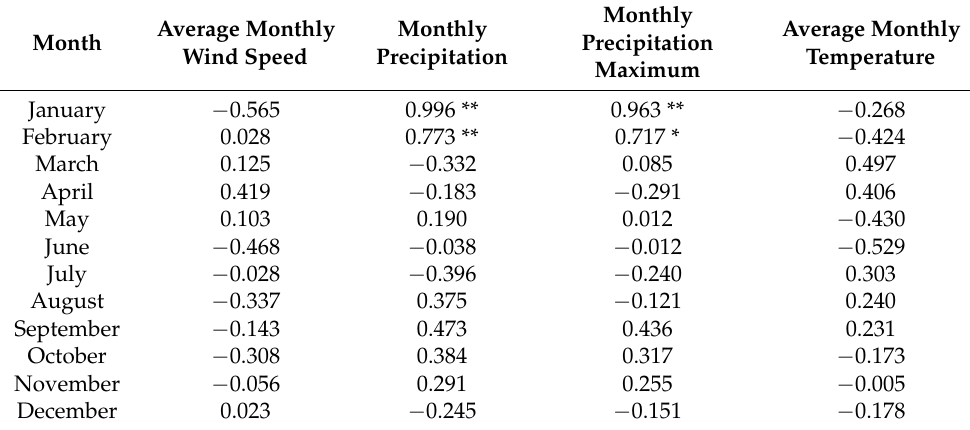
Table 4. Correlation coefficients between meteorological factors from different months and monthly total litterfall productions.